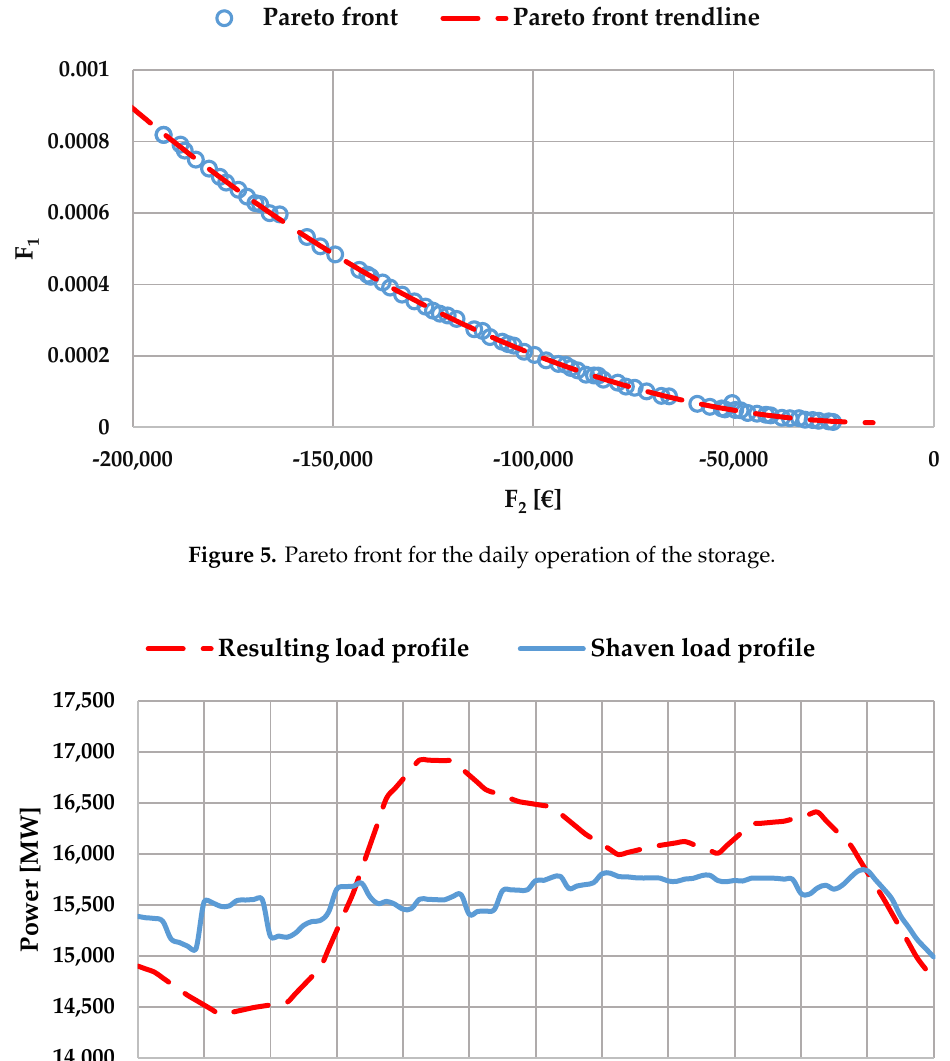
Figure 7. Daily operation of the storage in the dynamic pricing environment.